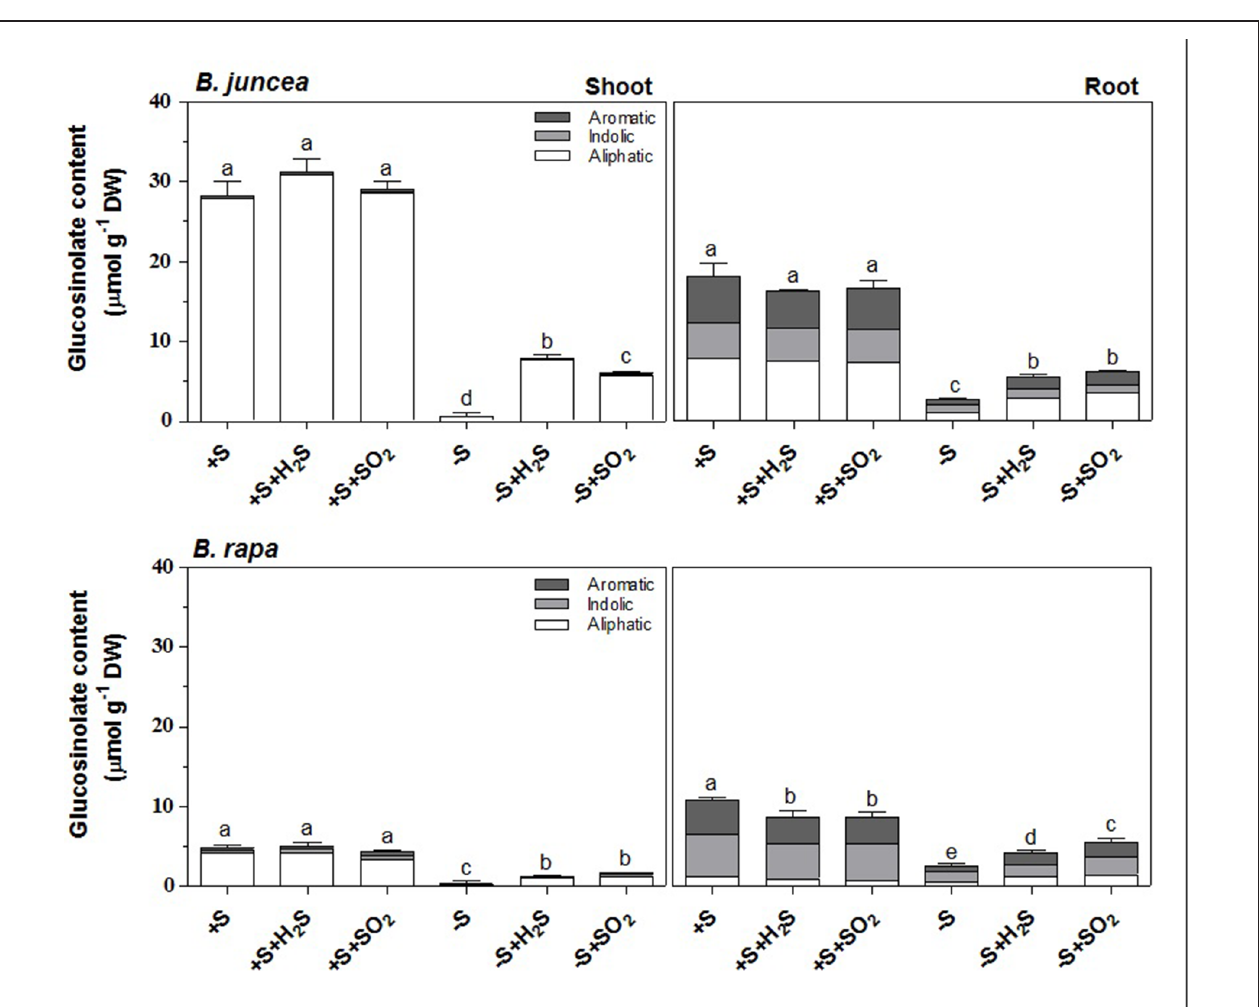
FIGURE 1 | Impact of H 2 S and SO 2 and sulfate deprivation on the content and composition of glucosinolates in shoots and roots of Brassica juncea and B. rapa . 10 day-old seedlings were grown on a 25 % Hoagland solution containing 0.5 mM sulfate for 3 days and subsequently transferred to fresh 25% Hoagland solution at 0 ( − S) or 0.5 mM sulfate ( + S) and exposed to 0.25 μ l l − 1 H 2 S or SO 2 for 7 days. The content of the aliphatic (white bars; μ mol g − 1 DW), indolic glucosinolates (gray bars; μ mol g − 1 DW) and aromatic (dark gray bars; μ mol g − 1 DW) represent the mean of three measurements with nine plants in each ( ± SD). Different letters indicate significant differences between treatments ( P < 0.01, Student’s t -test).